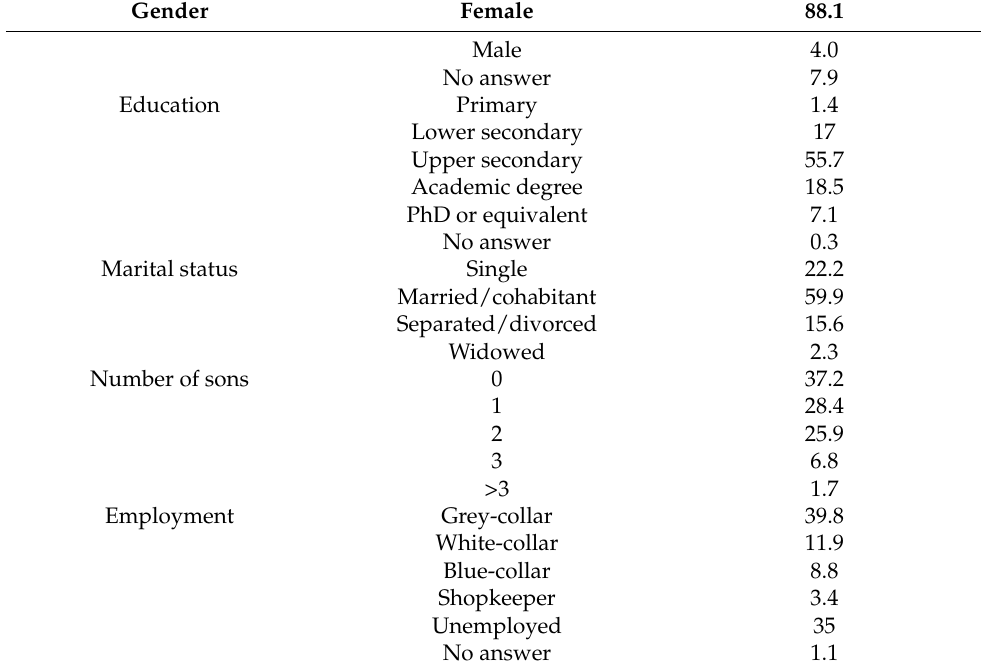
Table 1. Percent frequencies of demographics in the sample of participants (n = 352).